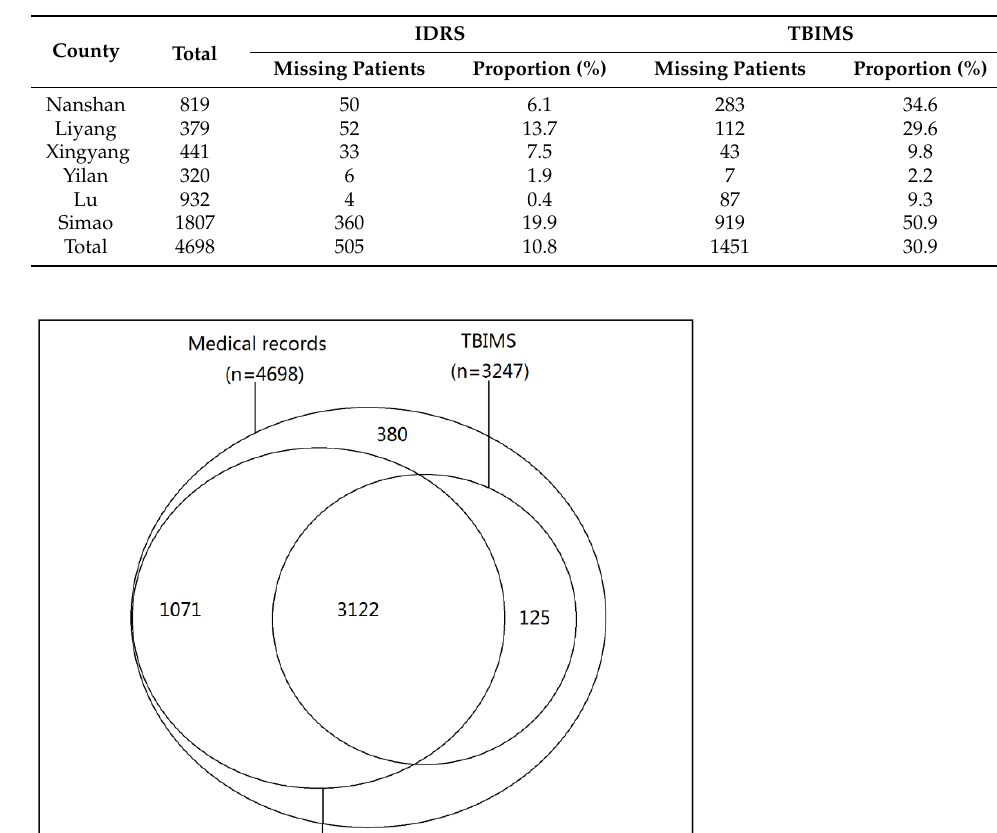
Table 2. The number and percentage of diagnosed TB patients missing from Infectious Disease Reporting System (IDRS) and Tuberculosis Information Management System (TBIMS) in six counties in 2016.